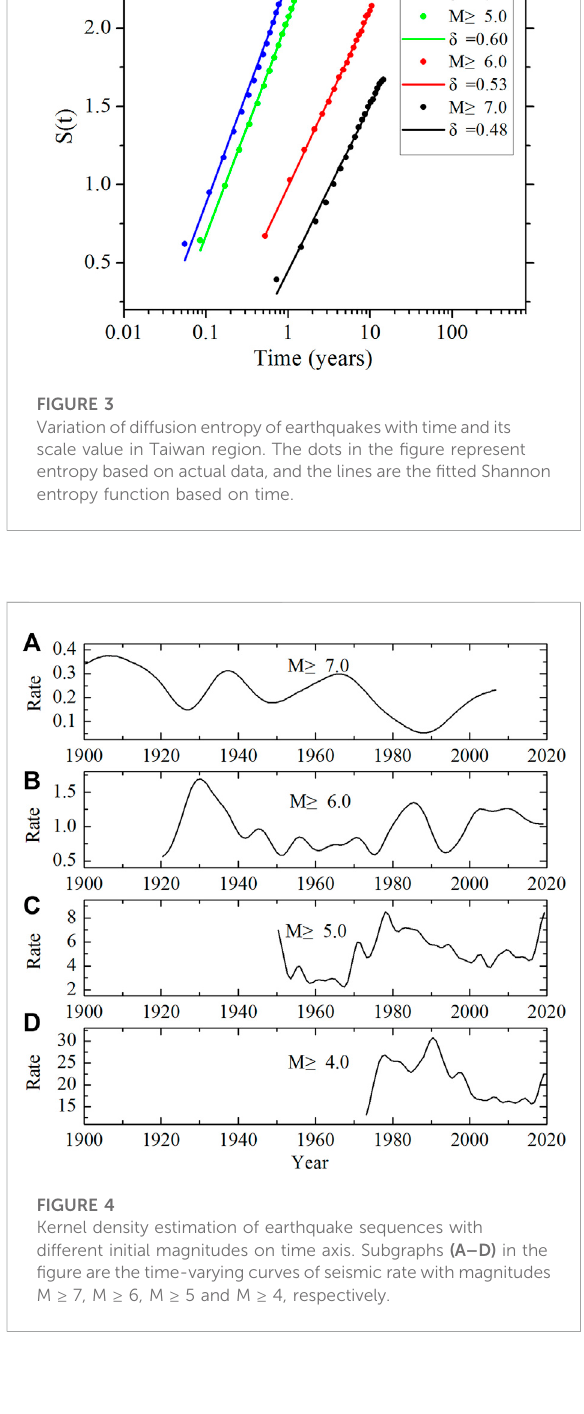
Figure 2C. For M W ≥ 7.0 earthquakes, the values of AIC, BIC,